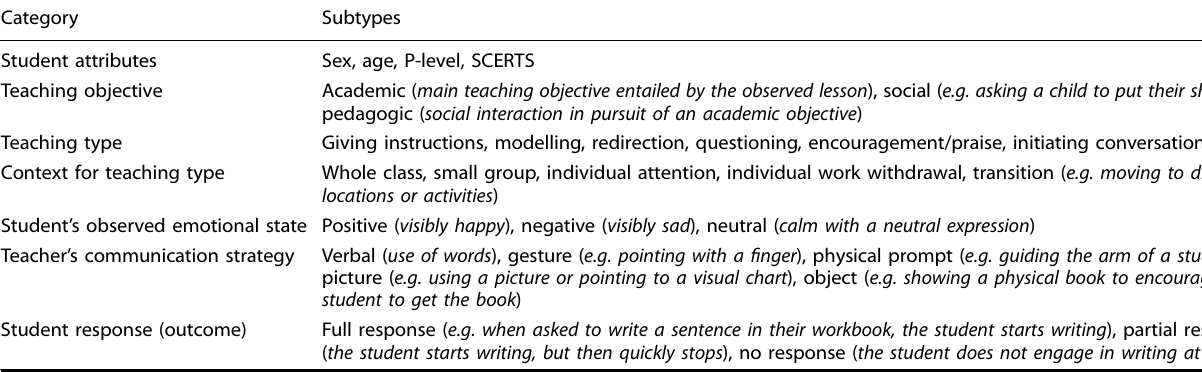
Table 1. Categories of information that was collected (and subsequently used to build a classi fi er) by observing interactions between teachers and students with